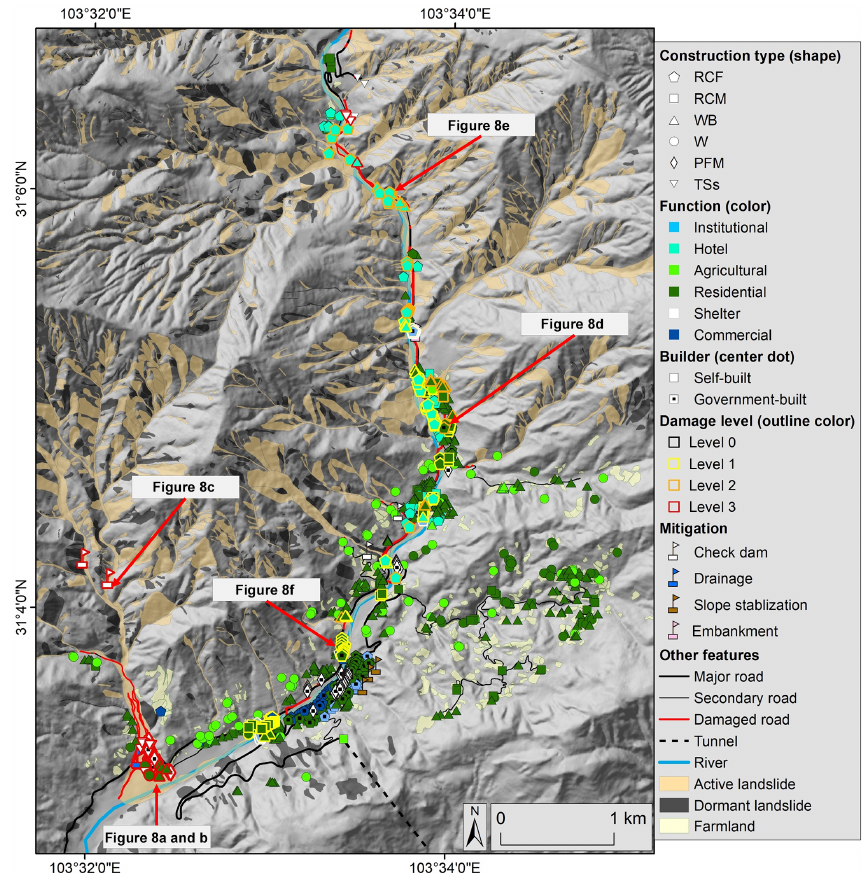
Figure 7. The building and landslide inventories mapped based on a WorldView-2 image captured in April 2011, showing the changes brought about by the August 2010 debris flow disaster. A total of 213 buildings were affected. The losses were largest for those buildings located either near subcatchment outlets or close to the